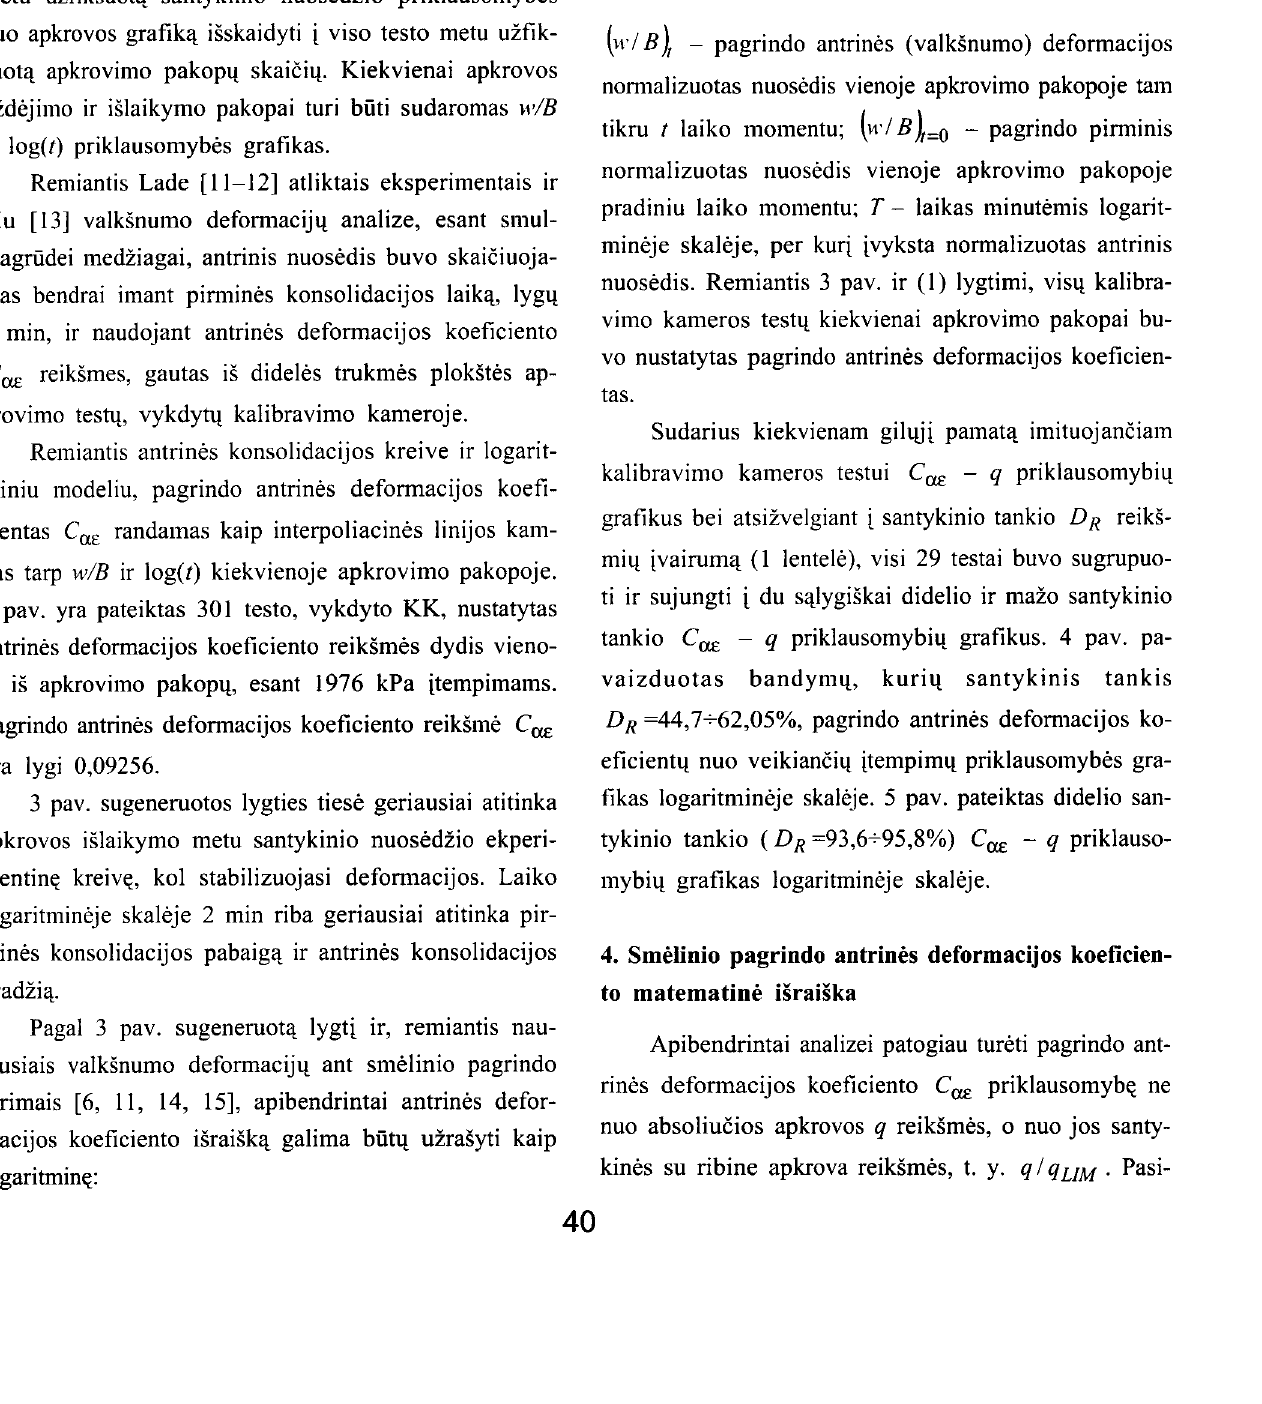
Fig 3. w/B vs. log